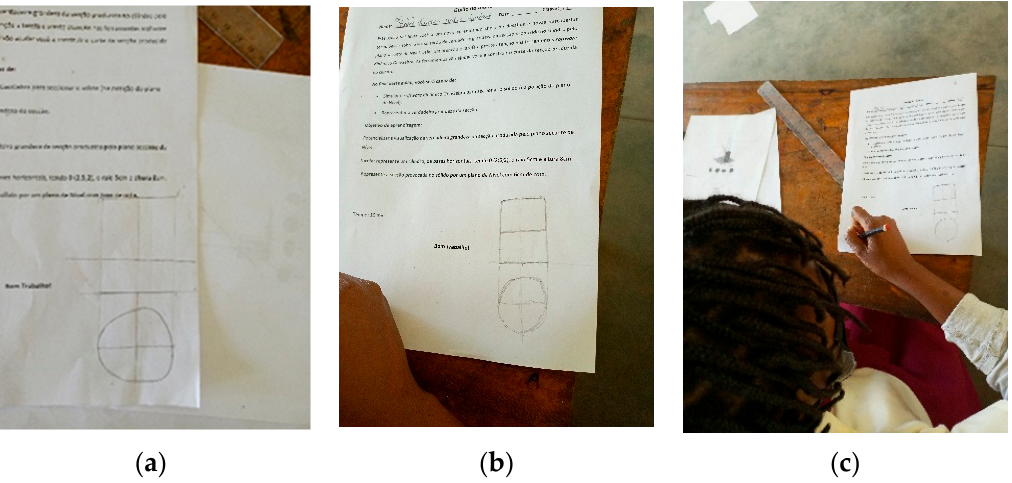
Figure 9. Post-test moment. ( a , b ) Post-test exercise; ( c ) student completing the post test.